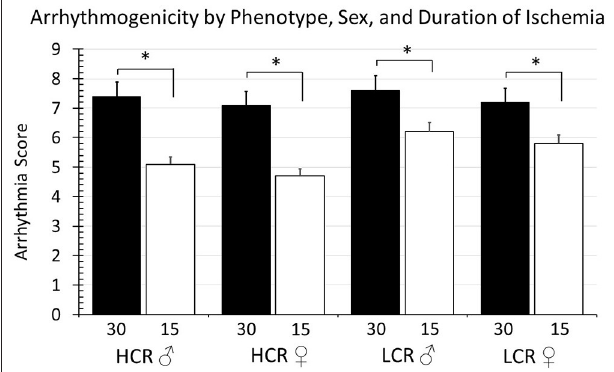
FIGURE 7 | Summary of arrhythmia scores according to duration of ischemia (30 vs. 15min), strain (HCR vs. LCR), and sex (males vs. female). There were significant differences in the severity of arrhythmia (* P < 0.05 for the comparison indicated), with 30min ischemic episode producing consistently higher arrhythmia scores than 15min events, however there were not significant differences between strain or between sexes with